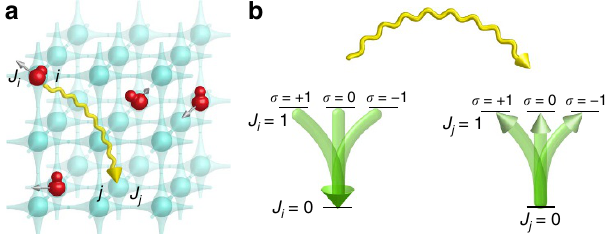
Figure 1 | Weyl quasiparticles in 3D dipolar arrays. ( a ) Schematics of the 3D lattice potential that traps an array of dipolar particles. The lattice is deep enough to pin the particles, most of which are prepared in the J ¼ 0 ground state (blue spheres). Only a few particles are excited to the J ¼ 1 states. Dipolar interactions between the J ¼ 0 and J ¼ 1 states give raise to Weyl excitations. ( b ) Schematics of dipole mediated interactions: an excited J ¼ 1 state of one particle can be transferred to another particle in the J ¼ 0 state by dipole–dipole interactions (virtual photon exchange is shown with a yellow wiggly line). Three types of allowed processes